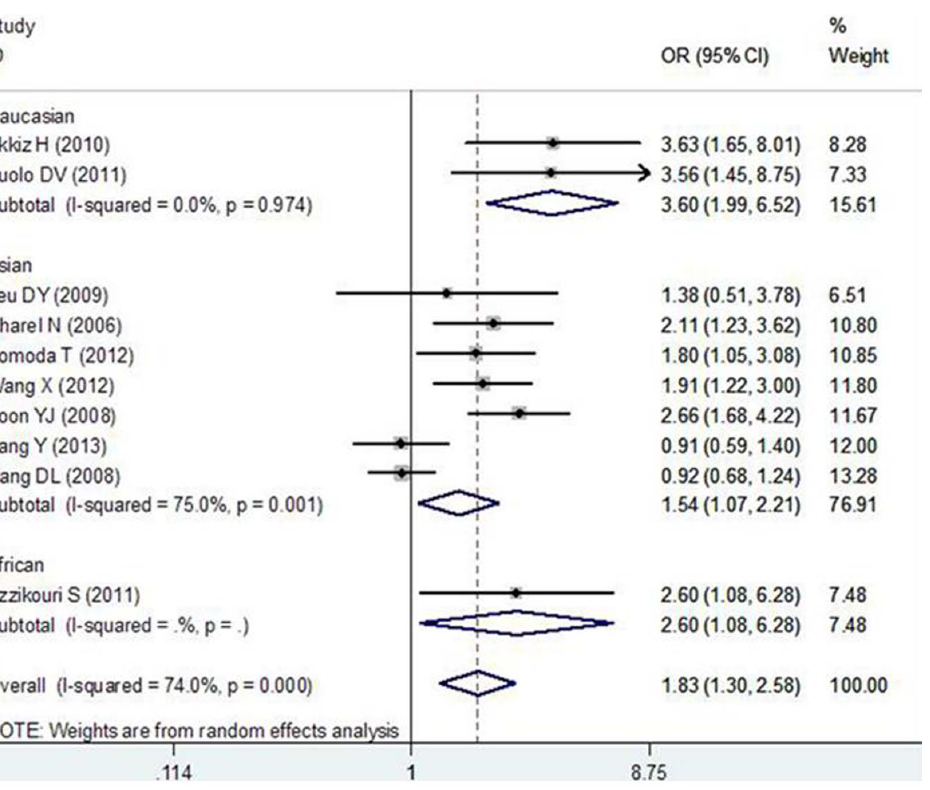
Figure 1. Subgroup analysis by ethnicity in the meta-analysis on the association between MDM2 SNP309 polymorphism and HCC risk using a random-effect model (additive model GG vs. TT).